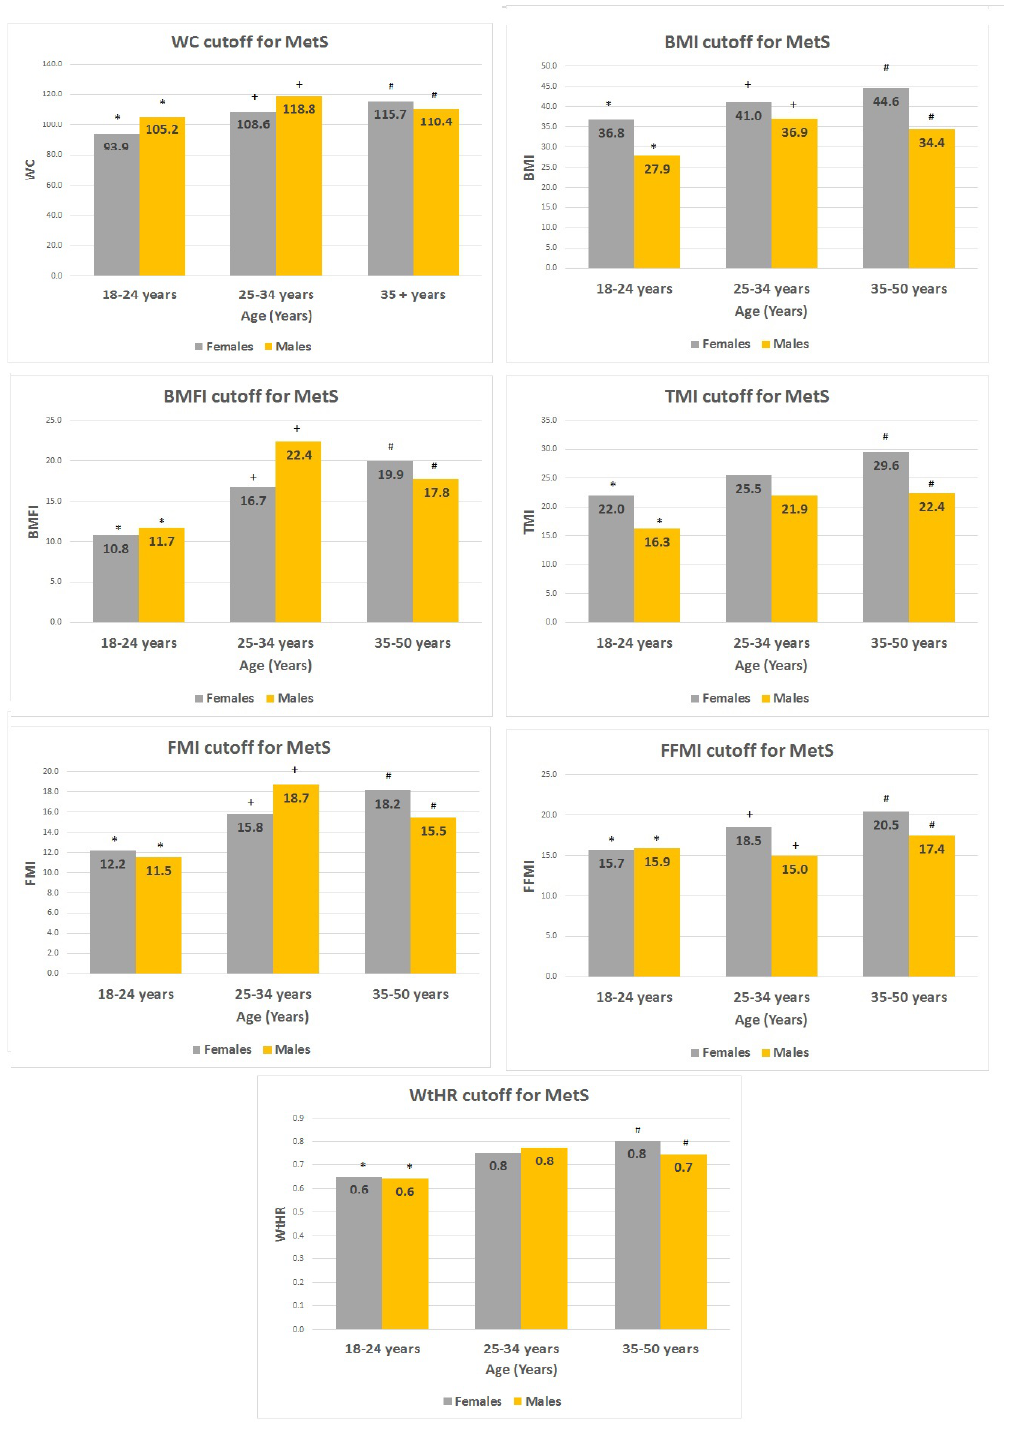
Figure 2. The threshold values of each index, beyond which MetS is identified, subdivided for sex and three di ff erent age groups. Within the columns, at the top, the exact threshold value is reported. * for the di ff erence ( p < 0.05) between 18–24 years and 25–34 years; + for the di ff erence ( p < 0.05) between 25–34 years and 35–50 years; # for the di ff erence ( p < 0.05) between 18–24 years and 35–50